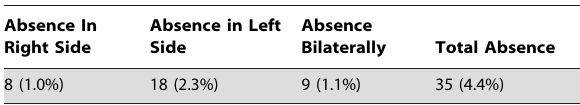
Table 3. Distribution of Palmaris Longus Absence.